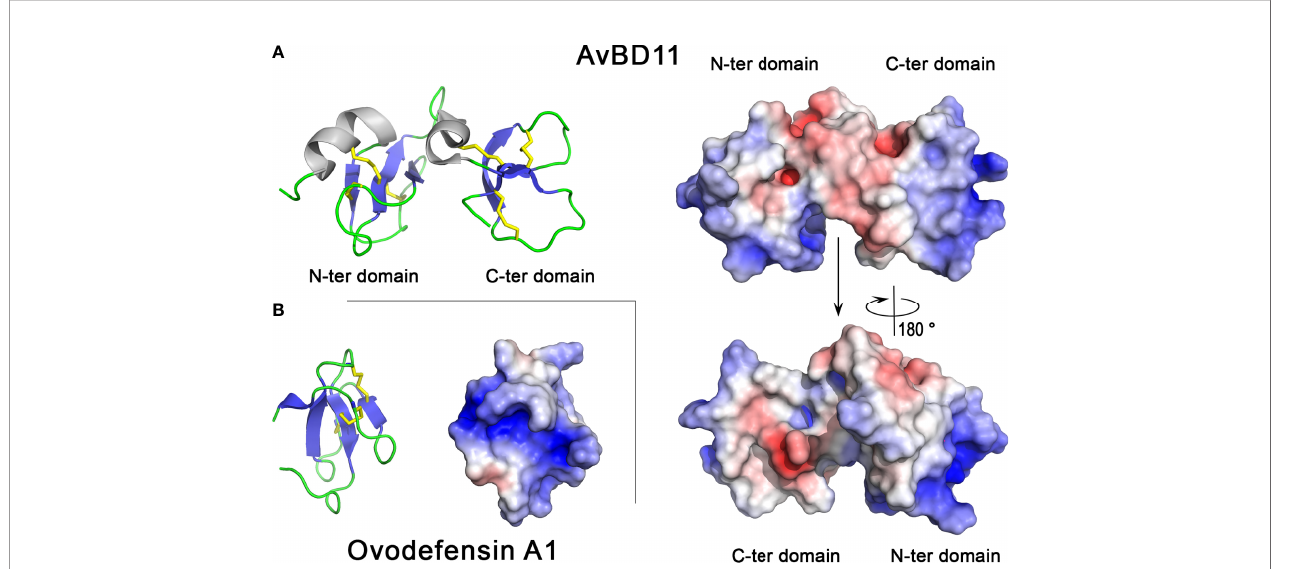
FIGURE 4 | 3D structures of chicken defensins AvBD11 and OvoDA1. 3D structure of chicken AvBD11 (A) and chicken OvoDA1 (B). The left panels correspond to the cartoon representation of 3D structure while the right panels show the color-coded electrostatic potential molecular surface. Color scheme ranges from red (negatively charged regions) to deep blue (positively charged regions). The fi gure was prepared using Pymol software (48) and APBS (Adaptive Poisson-Boltzmann Solver) plugin (49) for electrostatic calculations using atomic coordinates of 6QEU and 2MJK PDB fi les (www.rcsb.org) for AvBD11 and OvoDA1 structure,